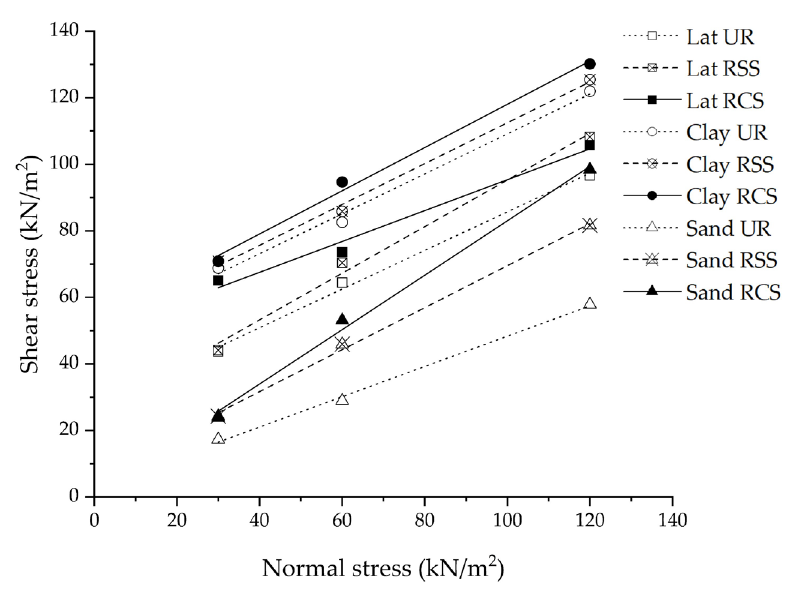
Figure 10. Mohr – Coulomb shear strength envelopes of sand, lateritic soil, and clay at all conditions